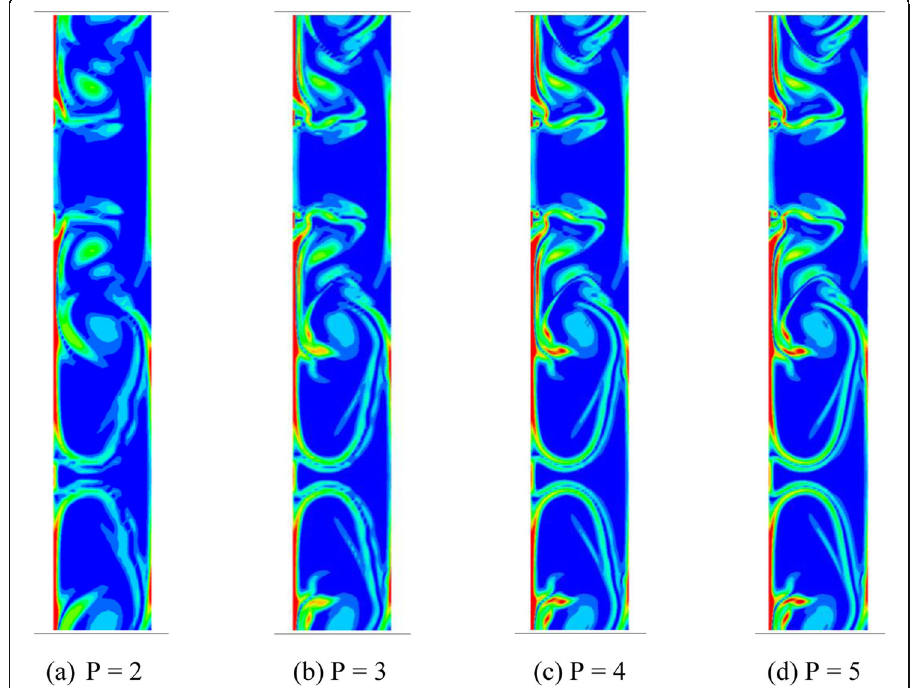
Fig. 5 The vorticity distributions at t 1 computed with different